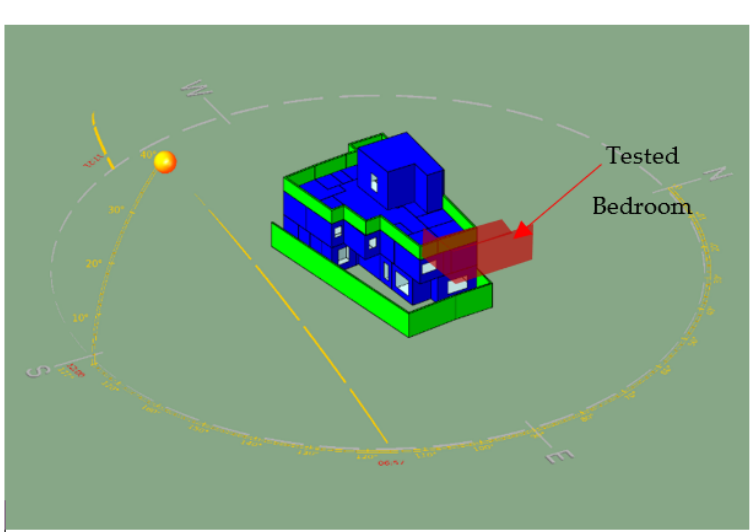
Figure 4. The Baseline Model built in IESVE.